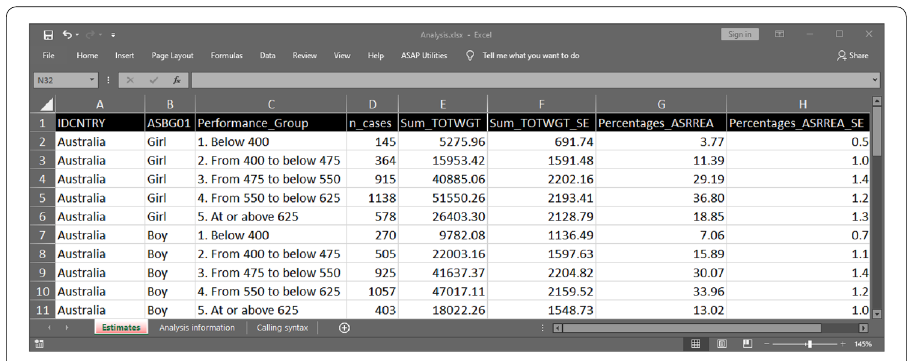
Fig. 3 Partial output from the lsa.bench